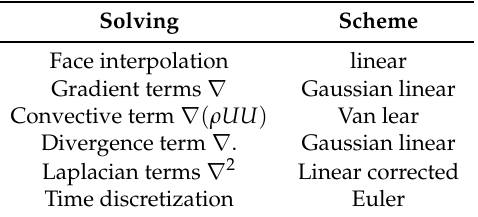
Table 3. Computational Fluid Dynamics (CFD) schemes [30].